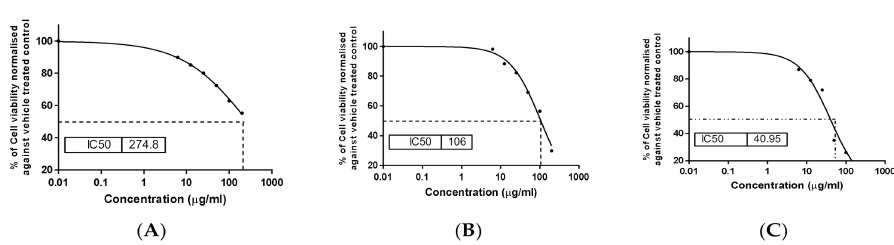
Figure 3. Evaluation of cell viability percentage of liver cancer cell line (Hep G2) posttreatment: ( A ) S. satureioides HD oil and ( B ) nanoemulsions of S. satureioides oil compared with reference drug